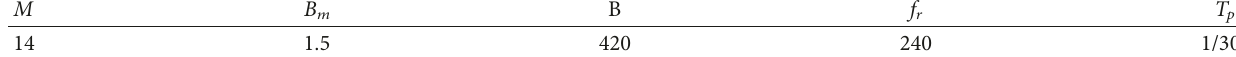
Table 1: Impact signal